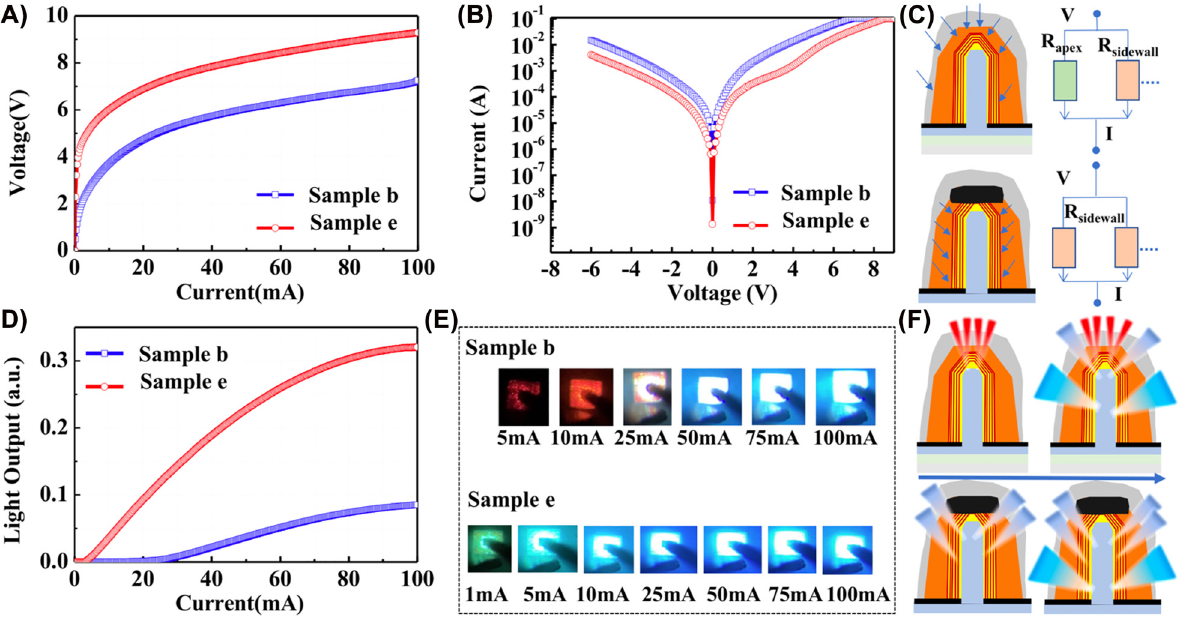
Figure 3: I – V – L curves, luminescence photos, and schematic images of the current injection paths in samples b and e. (A) I – V characteristic in samples b and e; (B) the corresponding V – I curves plotted in semi-log scale measured from − 6 to 9 V; (C) schematic distribution of current injection and corresponding circuits in samples b and e under the same voltage. (D) The current-light output of samples b and e as a function of injection current; (E) the luminescence photos in samples b and e, captured at different injection currents; (F) schematic diagrams of the emission region in NWs with and without (0001) plane MQS, at low and high injection currents.